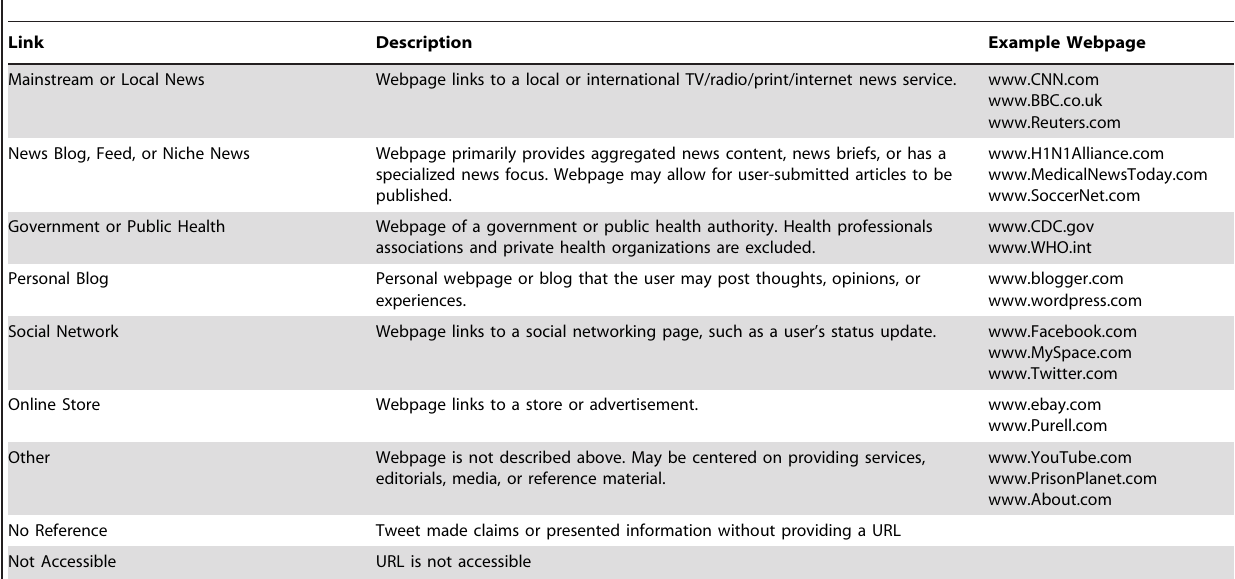
Table 3. Descriptions and Examples of Link